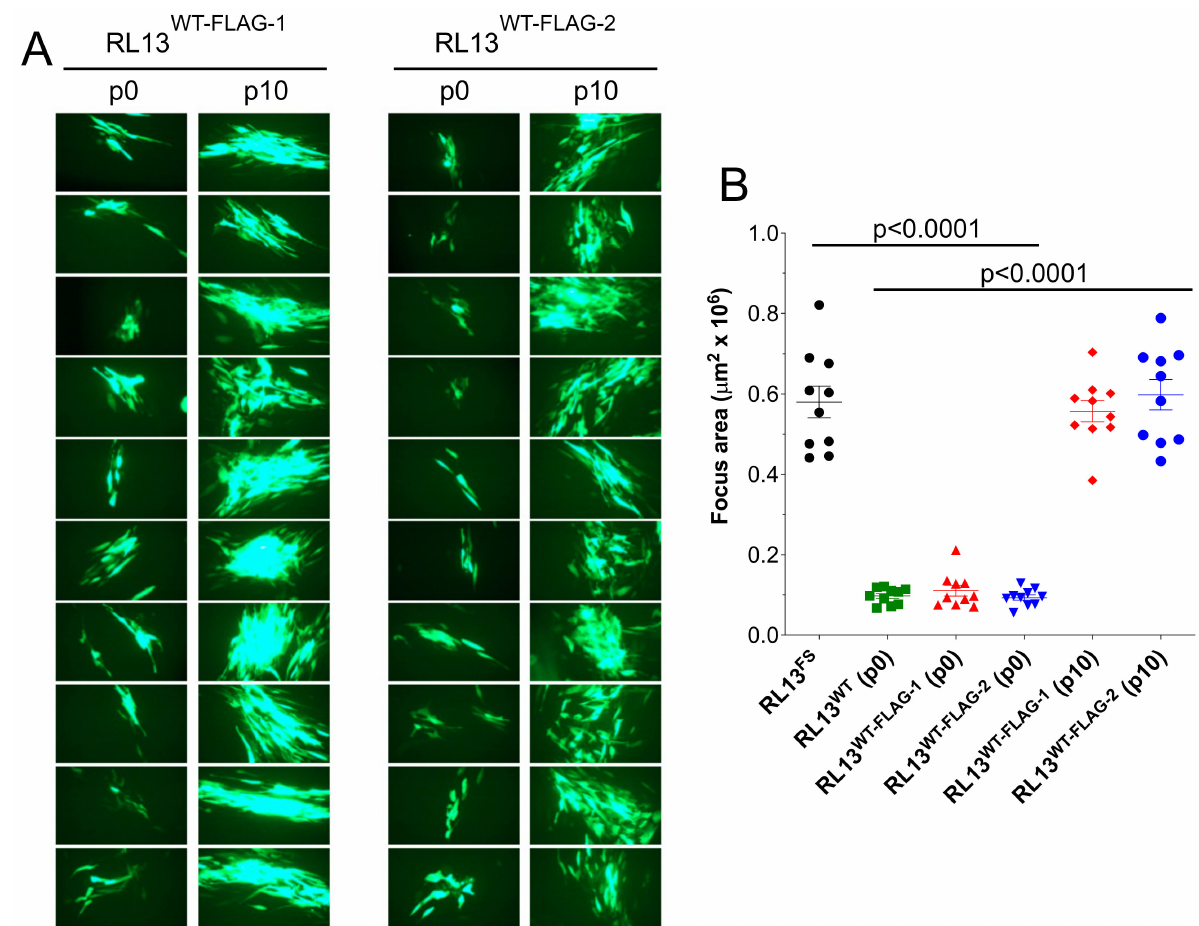
Figure 3. RL13-FLAG retains the ability to restrict focus size. Replicate p0 stocks of TL12- RL13 WT-FLAG were passaged as independent lineages, designated TL12-RL13 WT-FLAG–1 and TL12- RL13 WT-FLAG–2 , then used to infect MRC-5 fibroblast monolayers at low MOI. After eight days, GFP+ foci were photographed ( A ) and their surface areas measured ( B ) as described for Figure 2. Data for viruses TL12-RL13 FS and TL12-RL13 WT from Figure 2 are included for comparison ( p values from Student’s two-tailed t -test). Original magnification: 100 ×